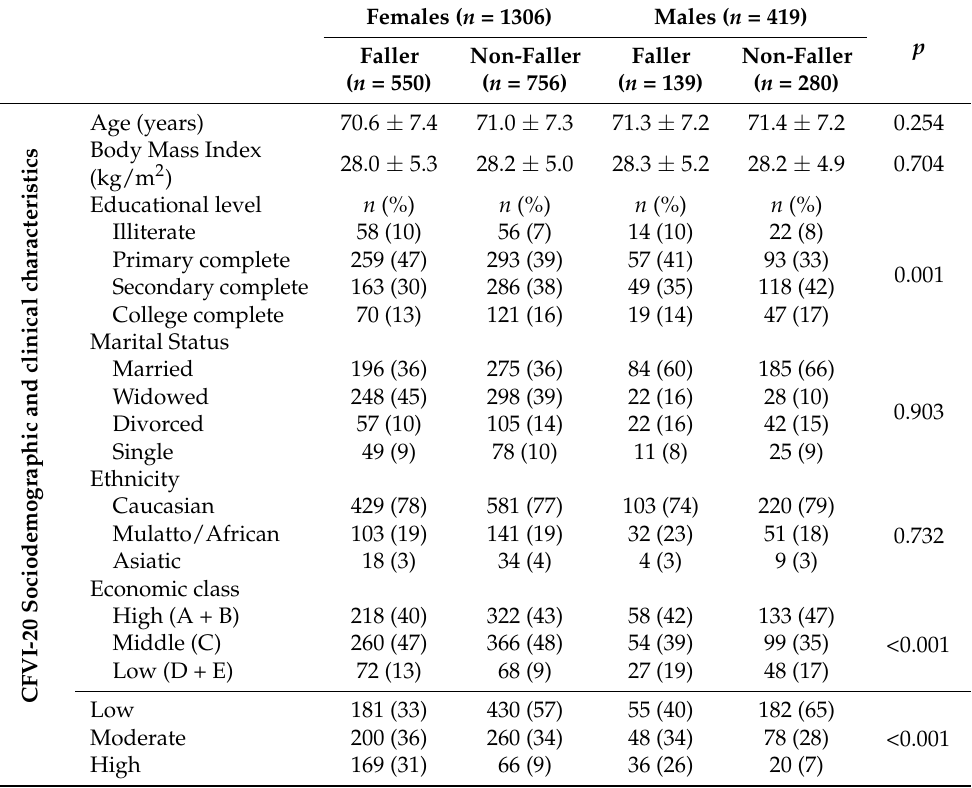
Table 1. Sociodemographic, clinical characteristics, and CFVI-20 data stratified by gender and falls history ( n =